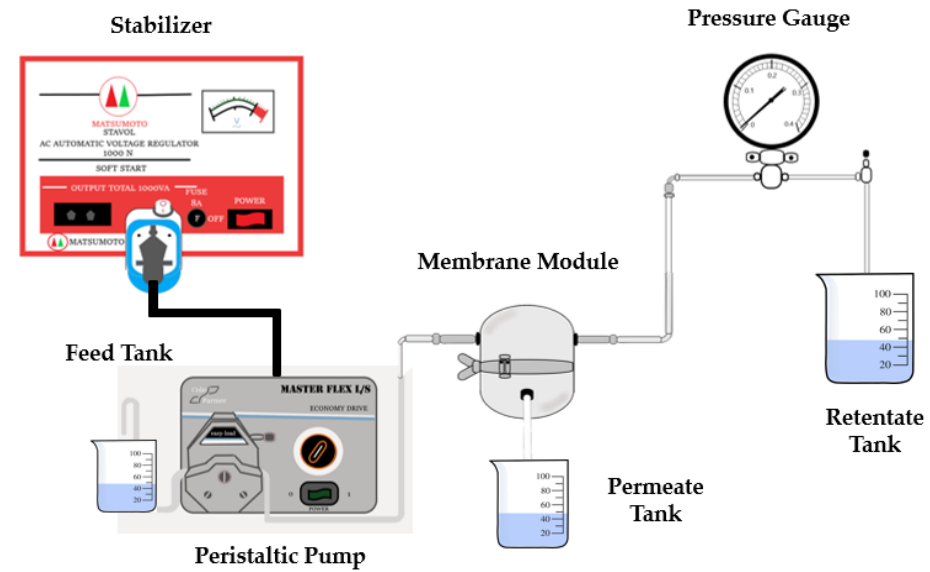
Figure 1. Crossflow ultrafiltration module for well-water filtration.